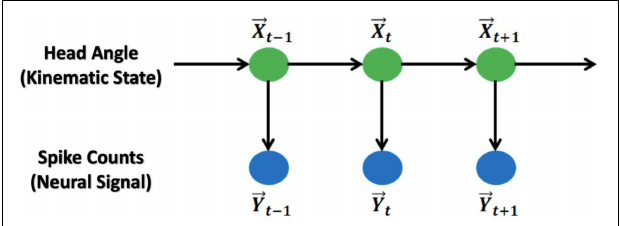
FIGURE 1 | Graphic representation of the Kalman Filter and Generalized Linear Model: The main model is a hidden Markov chain structure. HDs follow a Markov chain and spike counts at the current time bin are independent from the counts from previous time bins.